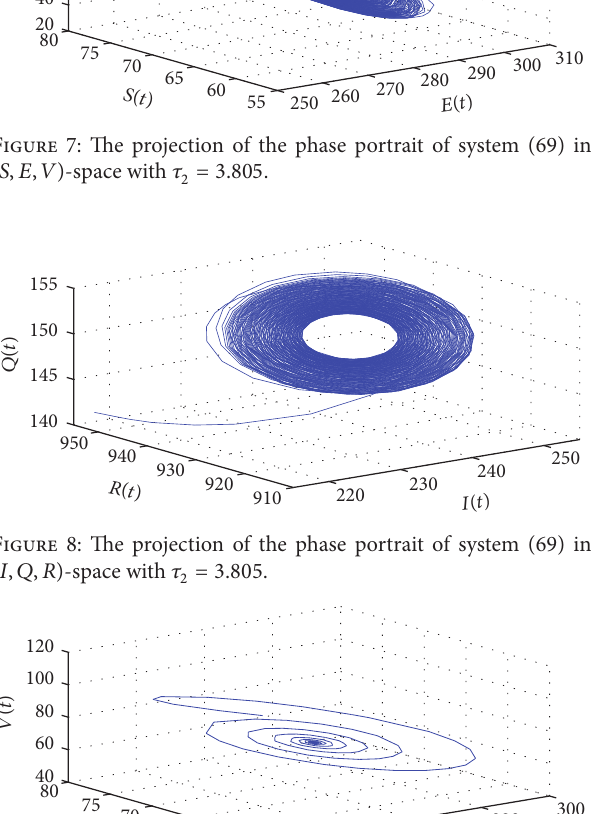
= 2.862 and 𝜏 = 2.45 ∈ (0, 𝜏 ) . 2 1 10